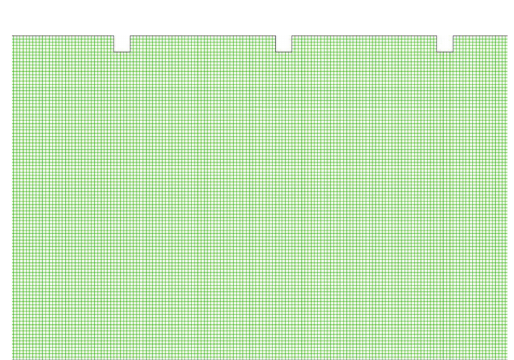
Figure 3: Visualization of uniform mesh